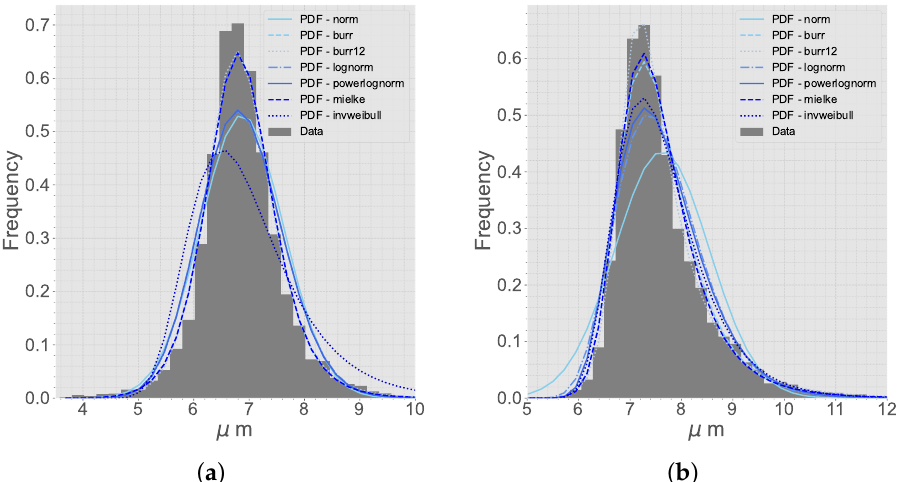
Figure 3. A selection of distribution functions fit to the extracted micrograph data. ( a ) First NN. ( b ) Second NN.